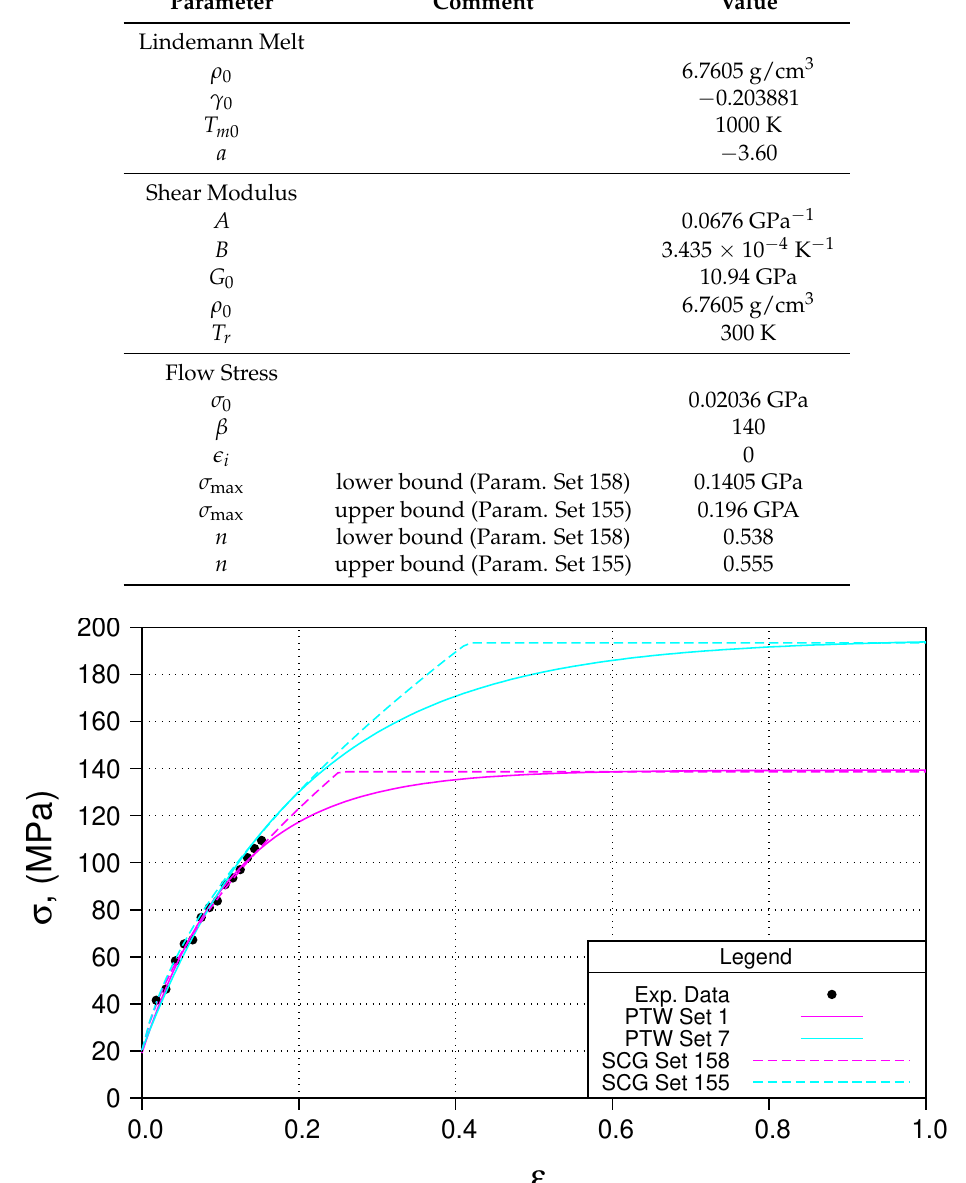
Table 3. SCG model for cerium.